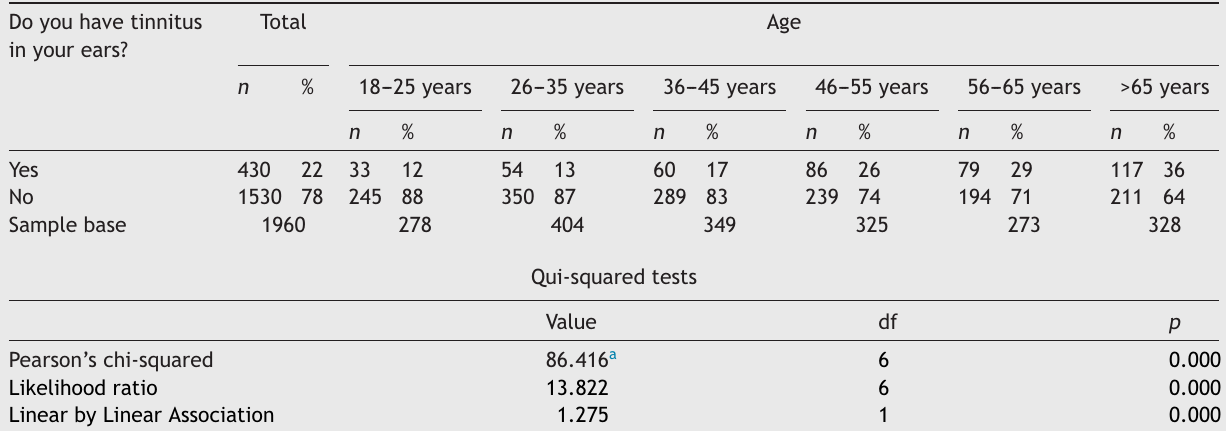
Prevalence of the reported symptom ‘‘tinnitus’’ according to the different age groups in the population of the city of São